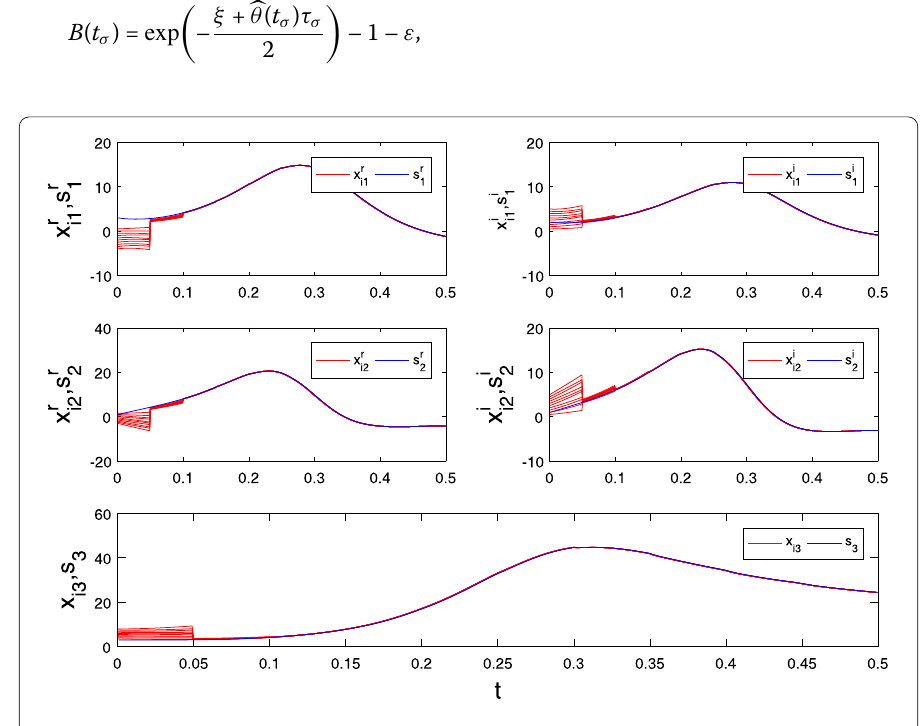
Figure 2 The orbits of the real and imaginary parts of x kl ( t ) and s l ( t